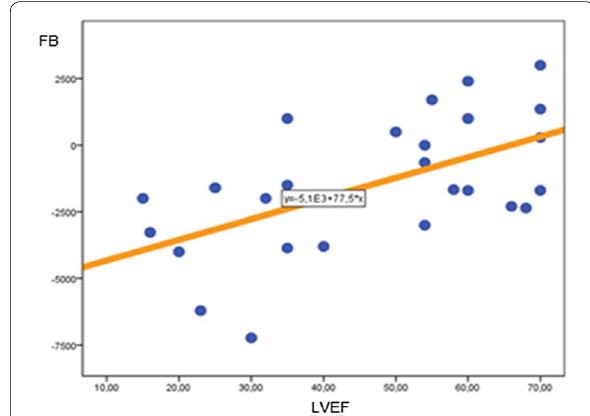
Fig. 1 Linear correlation between fluid balance at 48 h and left‑ventricular ejection fraction. Pearson correlation r P 0.002. FB fluid balance, LVEF left‑ventricular ejection =